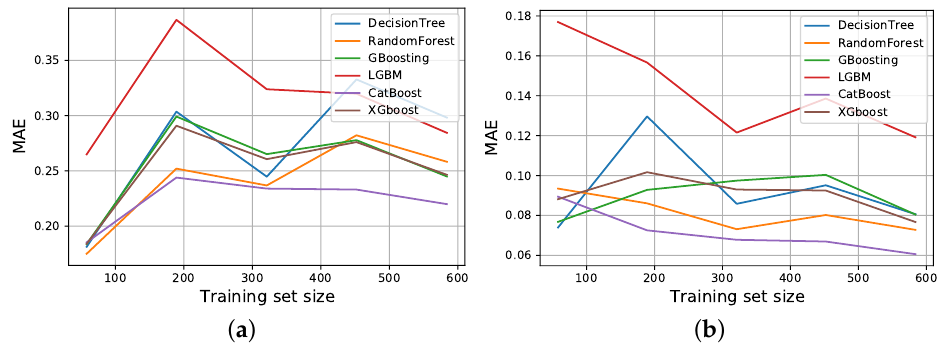
Figure 10. Learning curves of models for ( a ) right elbow and ( b ) left